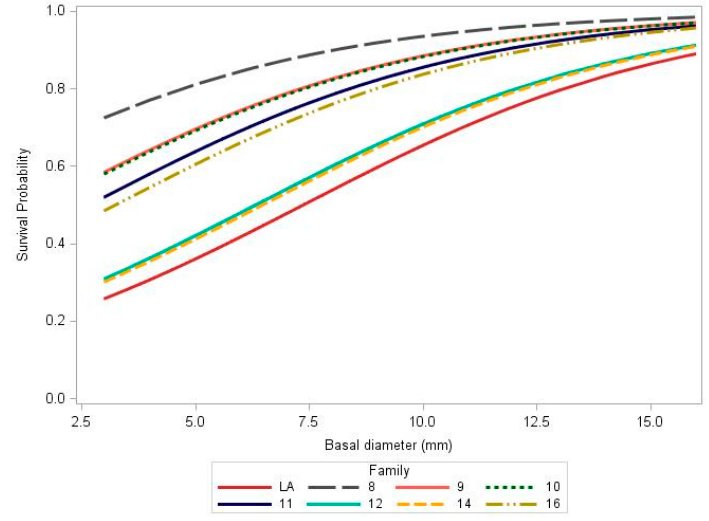
Figure 2. Regression model using family and basal diameter at planting to predict eleventh-year survival. LA indicates locally available seedling treatment.